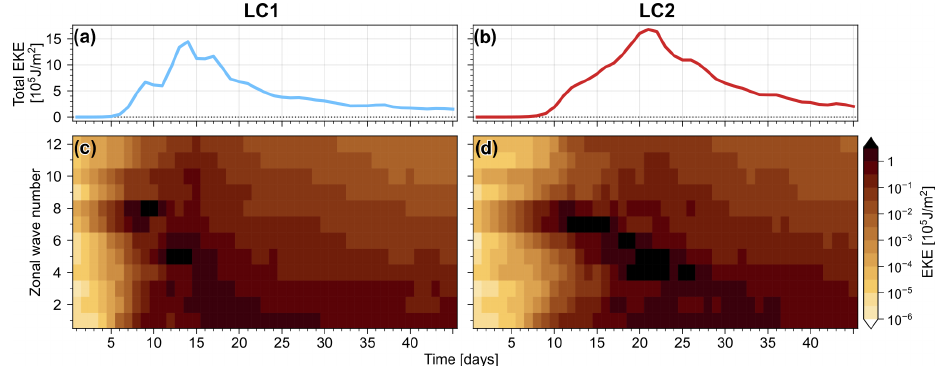
Figure 7. Evolution of EKE in experiments with LC1 (a, c) and LC2 (b, d) initial conditions and strong initial noise ( η = 10 3 ). The top row shows the total EKE, and the bottom row shows EKE for individual wave numbers – both as mean over three different noise realisations. Energies are shown as northern-hemispheric horizontally averaged and vertically integrated energy